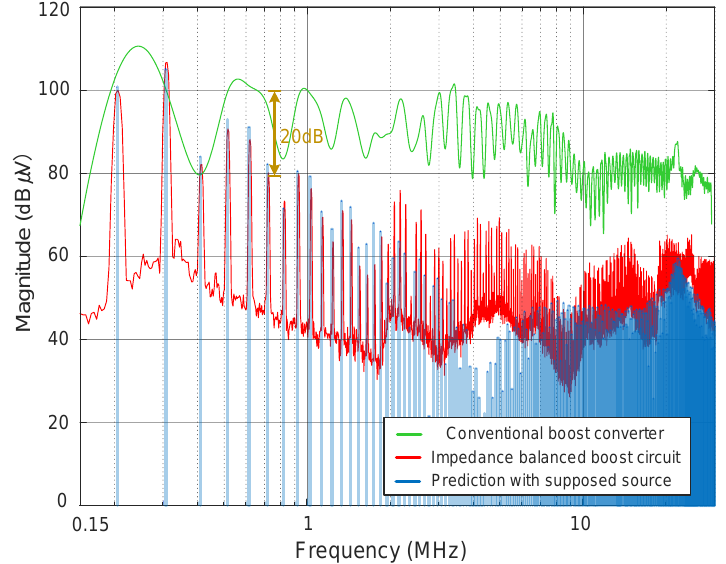
Figure 11. CM noise spectra comparison of balanced impedance circuit.